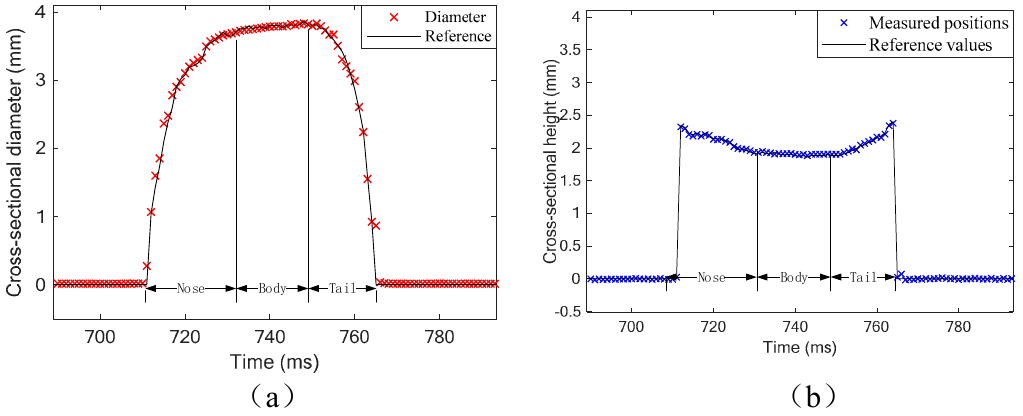
Figure 10. A typical group of experimental results: ( a ) cross-sectional diameter; ( b ) cross-sectional height.